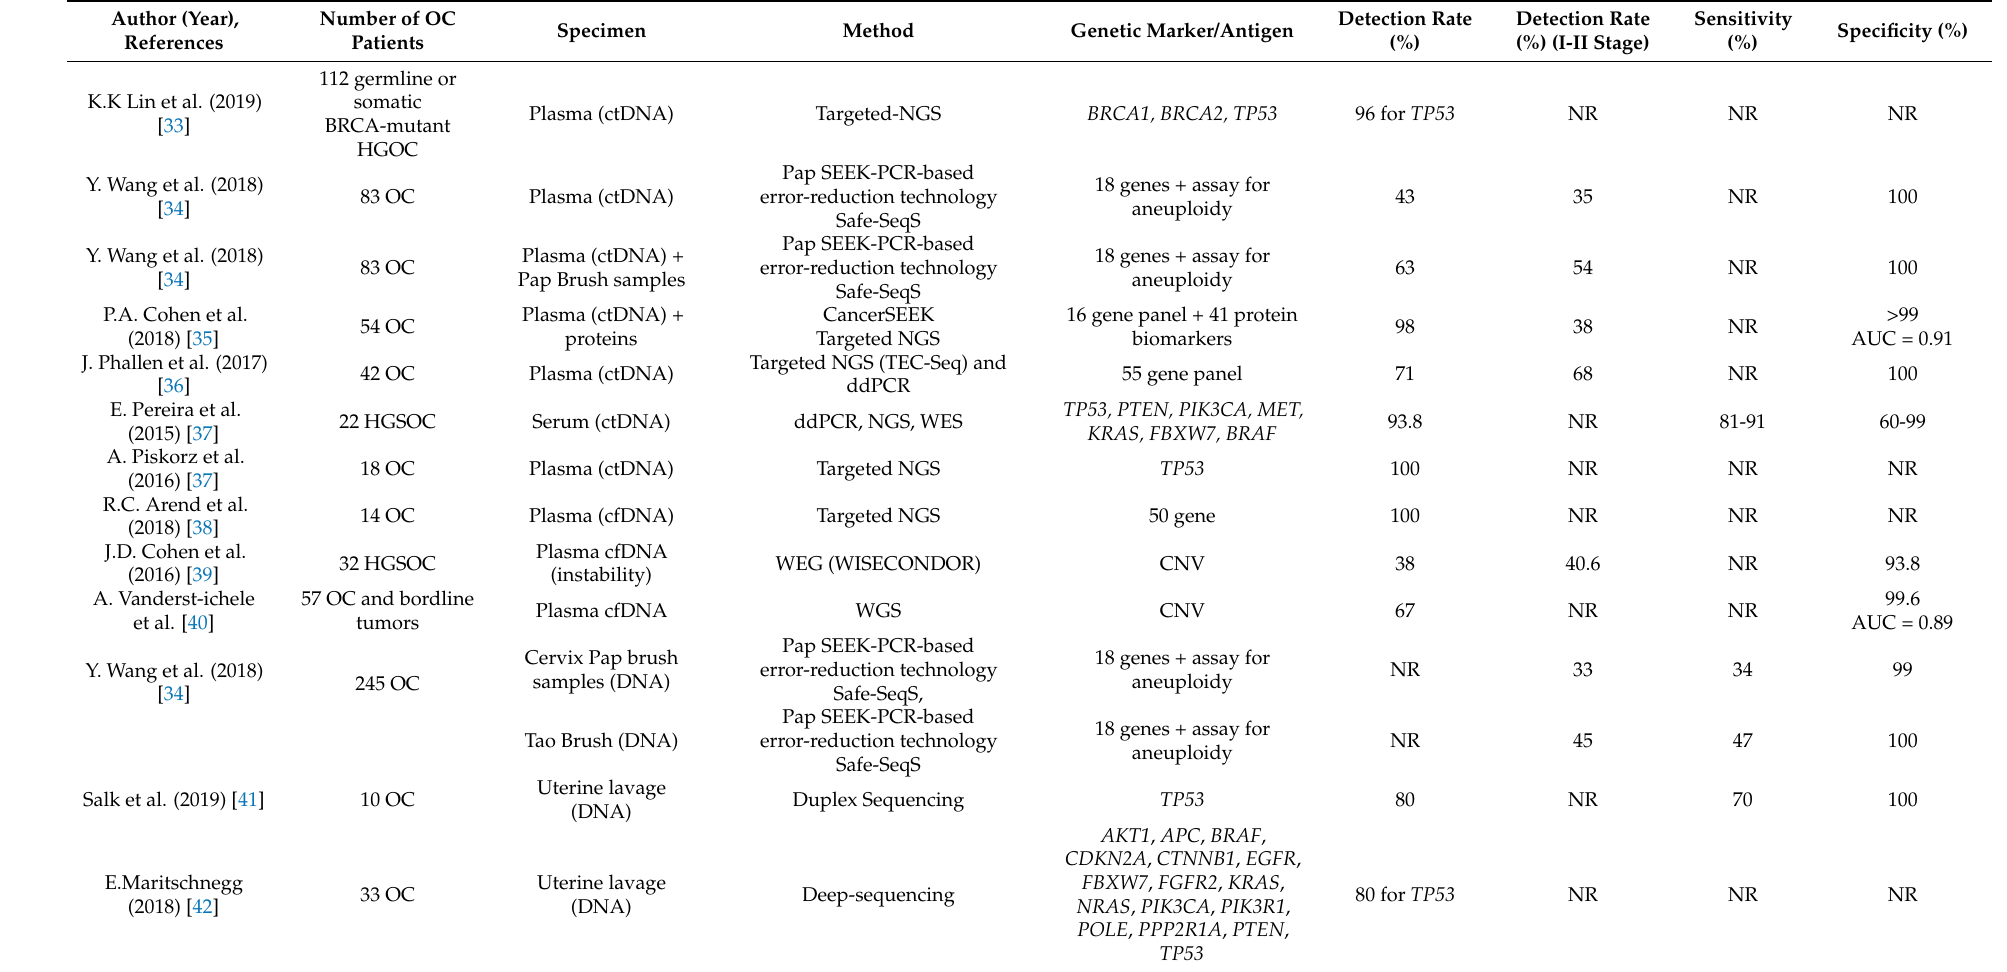
Table 2. Studies on ctDNA, DNA, CTC and microRNA in ovarian